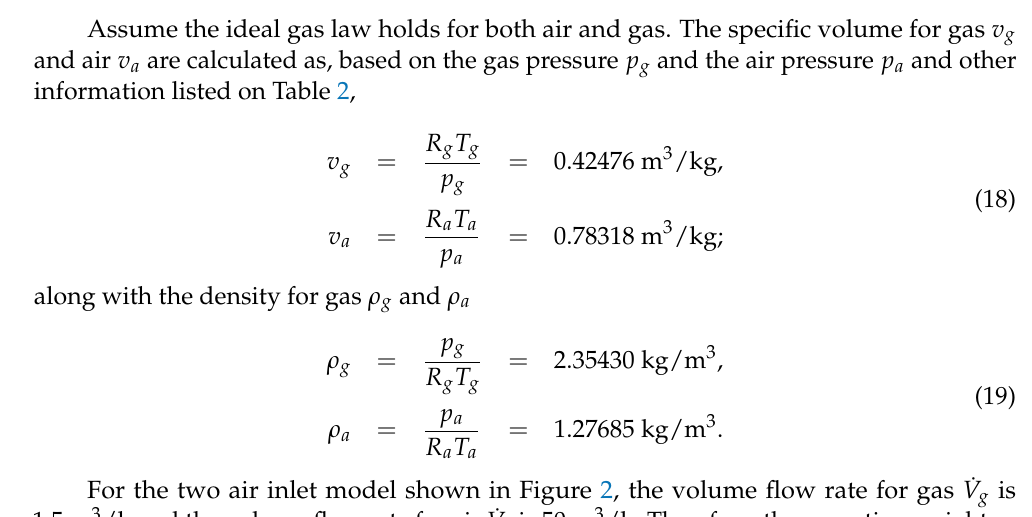
Figure 2. Mesh details for the center gas inlet and boundary conditions in three-dimensional ADINA